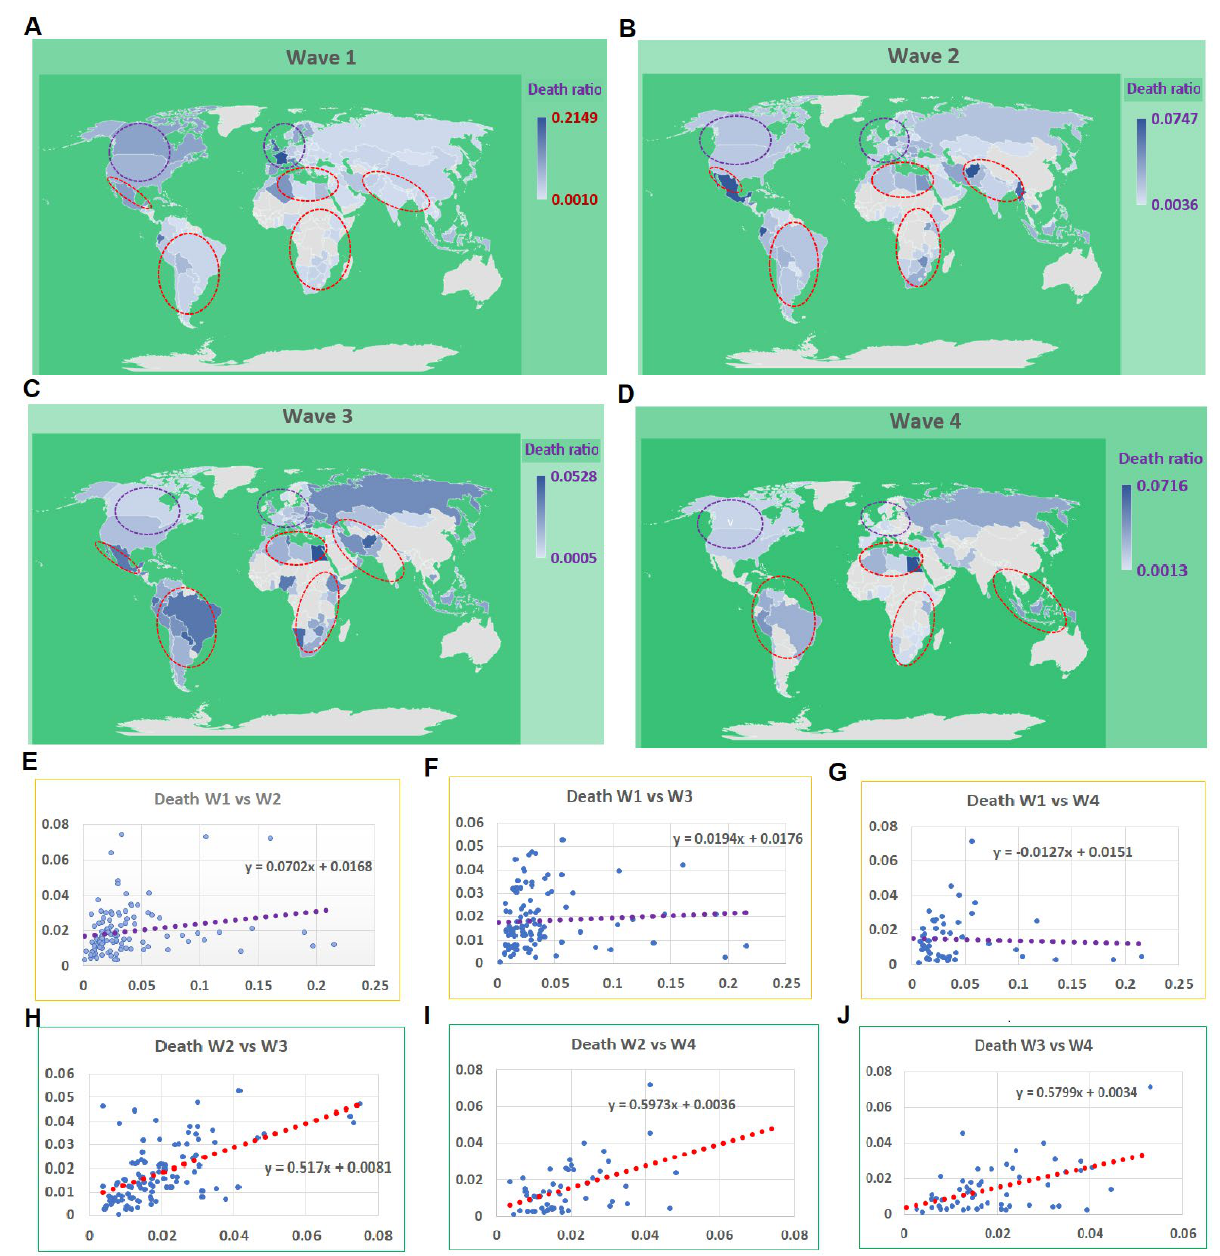
Figure 1. Mortality at the case turning point of the COVID-19 pandemic for 119 countries and regions (CRs). Blue circles indicate the developed CRs, and red circles indicate developing CRs. ( A – D )